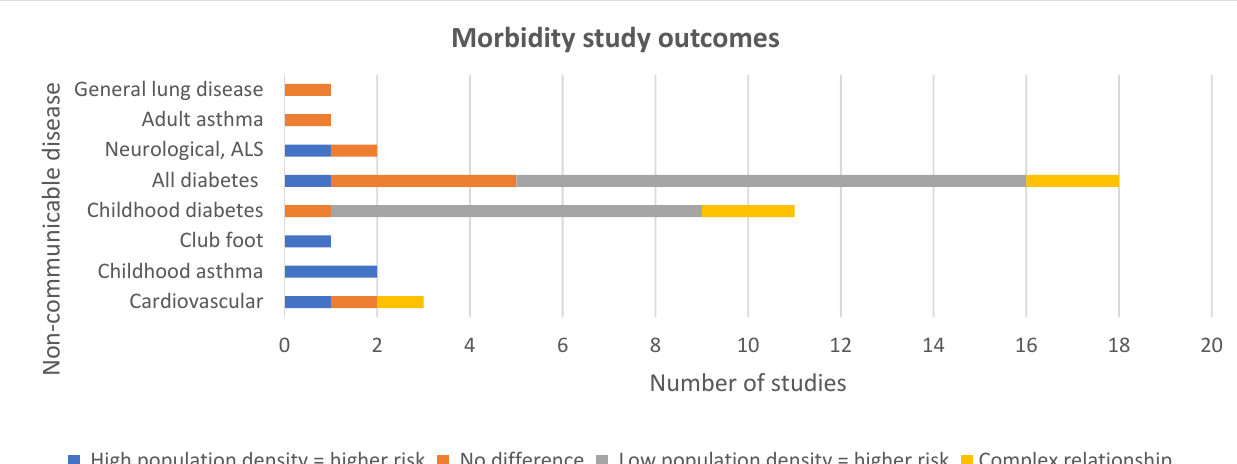
Figure 6. Morbidity study outcomes.